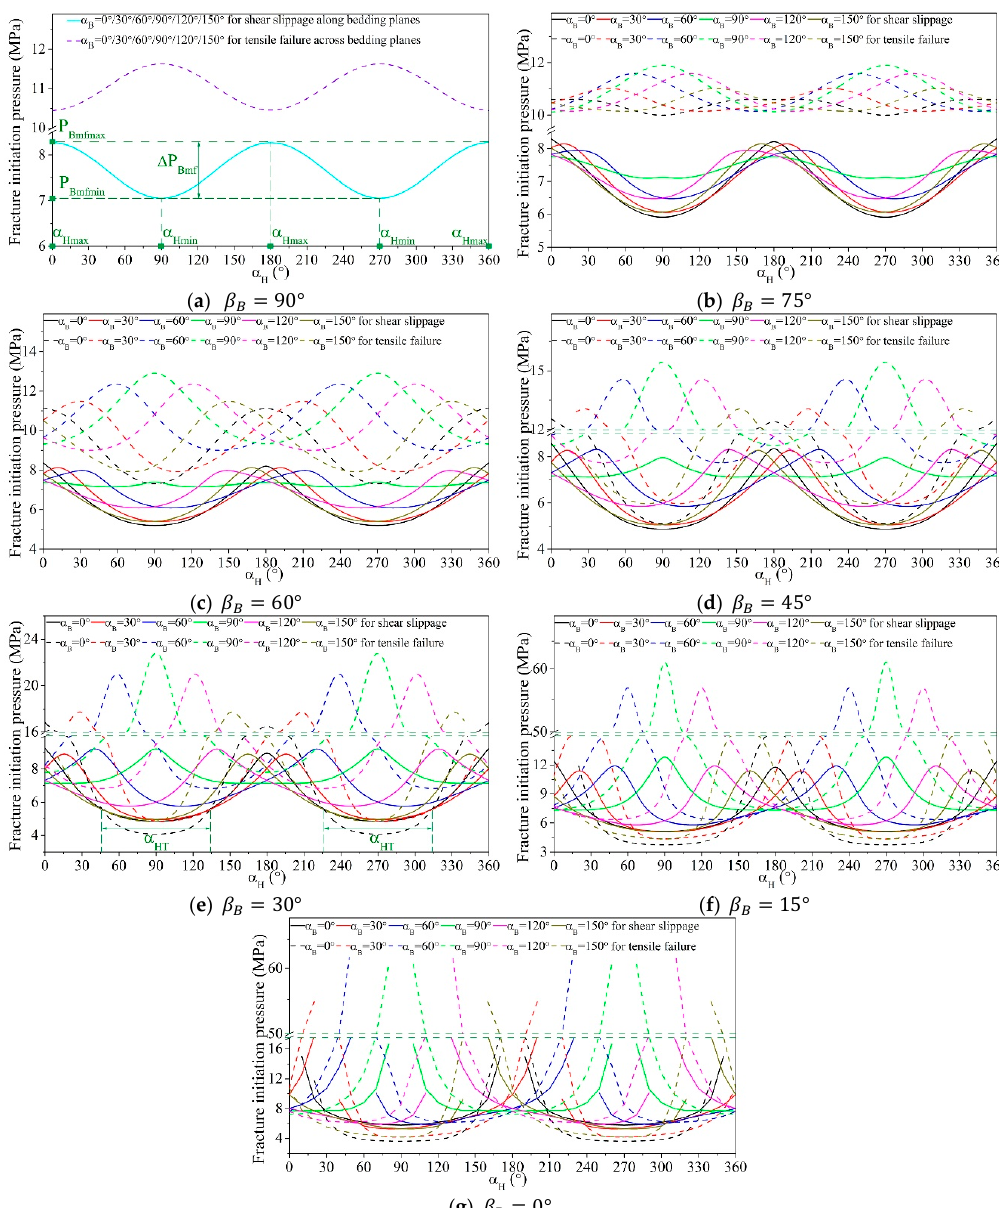
Figure 8. Variation in fracture initiation pressure of the bedding planes with drilling direction for di ff erent bedding planes for the dip angle of ( a ) 0 ◦ , ( b ) 15 ◦ , ( c ) 30 ◦ , ( d ) 45 ◦ , ( e ) 60 ◦ , ( f ) 75 ◦ , ( g ) 90 ◦ . The di ff erent colors (black, red, blue, green, magenta and dark yellow) represent di ff erent conditions corresponding to α B = 0 ◦ , α B = 30 ◦ , α B = 60 ◦ , α B = 90 ◦ , α B = 120 ◦ and α B = 150 ◦ , respectively. The di ff erent line styles (solid and dashed lines) represent the two di ff erent fracture initiation modes (shear slippage along the bedding planes and tensile failure across the bedding planes, respectively). Besides, the colors (cyan and violet) represent shear slippage along the bedding planes and tensile failure across the bedding planes when the change of α B makes no di ff erence to the